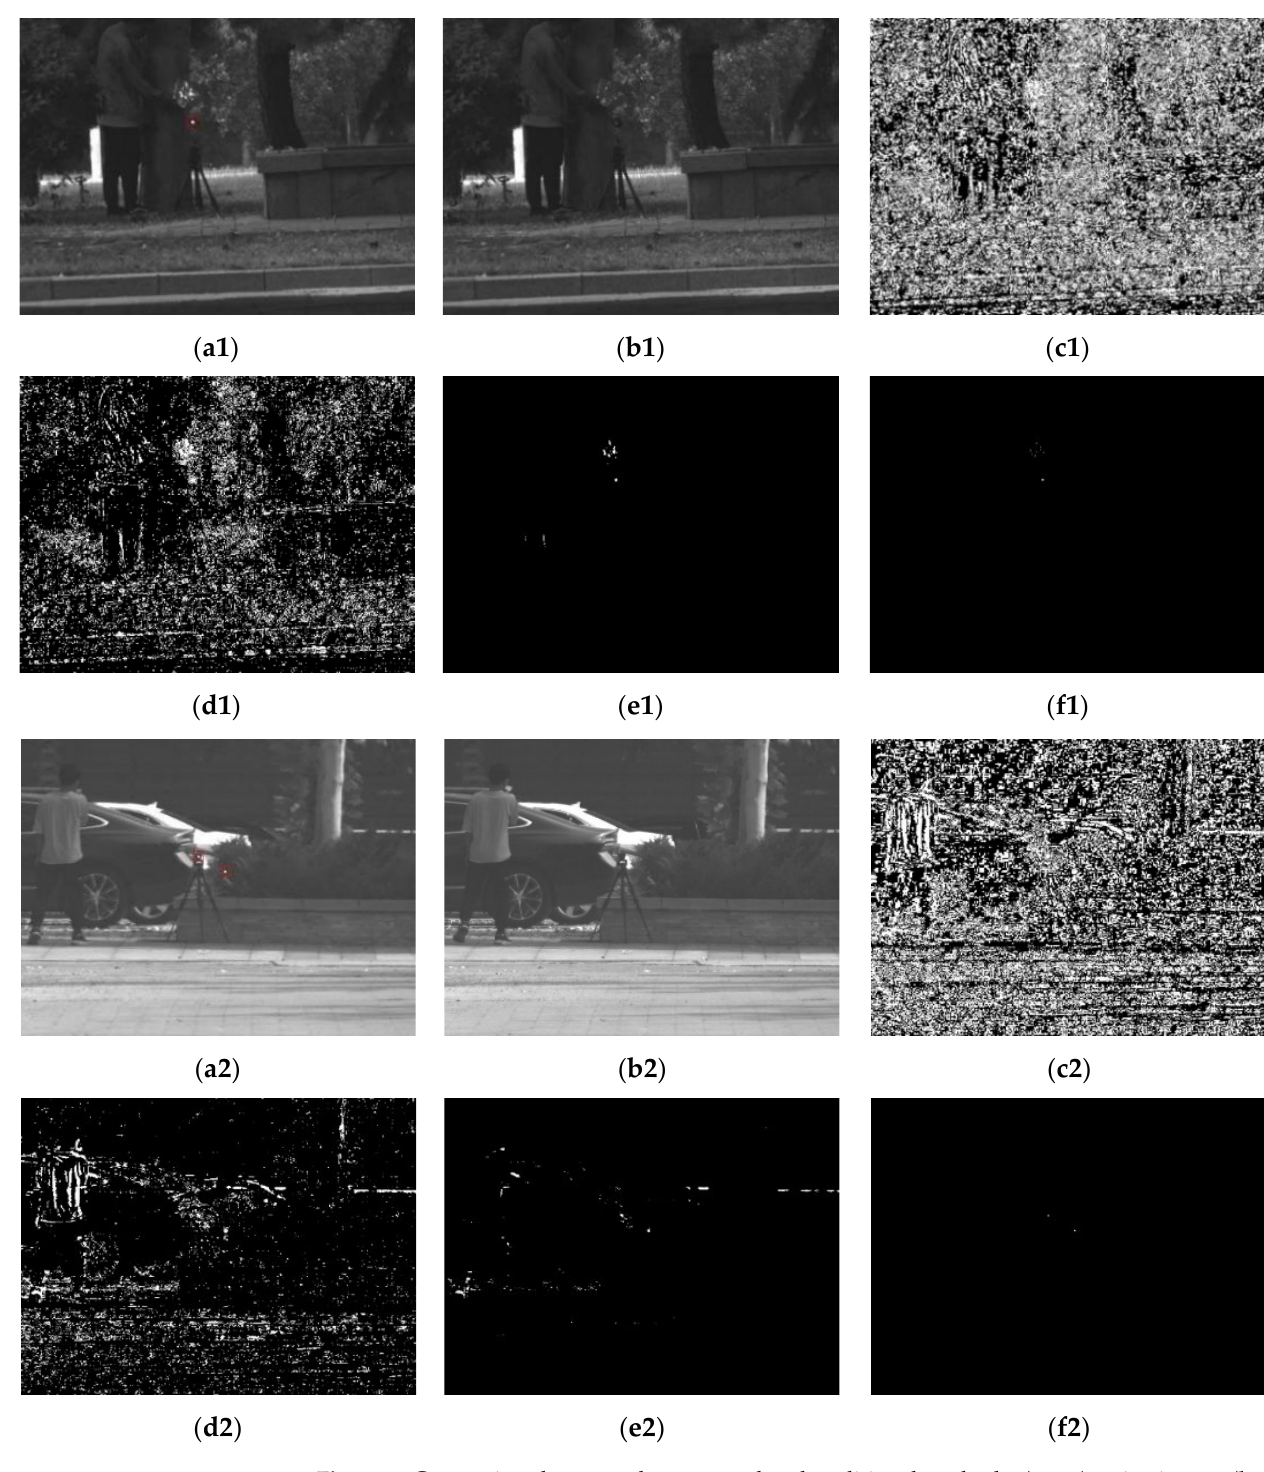
Figure 9. Comparison between the proposed and traditional methods: ( a1 , a2 ) active image, ( b1 , b2 ) passive image, ( c1 , c2 ) maximum entropy threshold segmentation, ( d1 , d2 ) iterative threshold segmentation, ( e1 , e2 ) Otsu-based threshold segmentation, ( f1 , f2 ) proposed threshold segmentation.